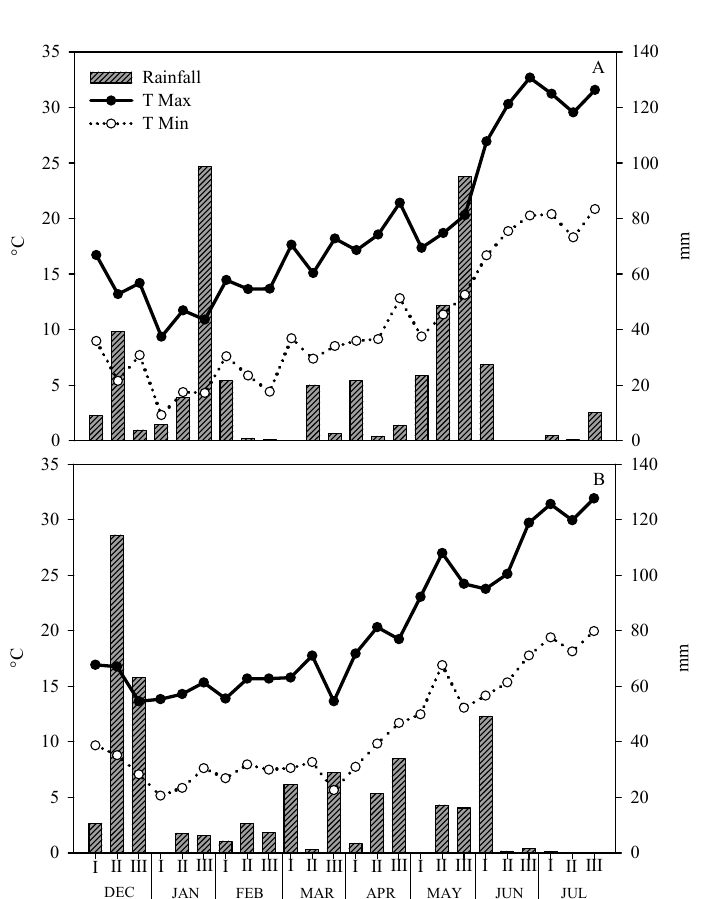
Figure 1. Maximum and minimum air temperature trends, and rainfall during the two growing seasons of Barley (2018–2019 = I Year ( A ); 2019–2020 = II Year ( B )). (I, II and III represent 10 days intervals of each month).